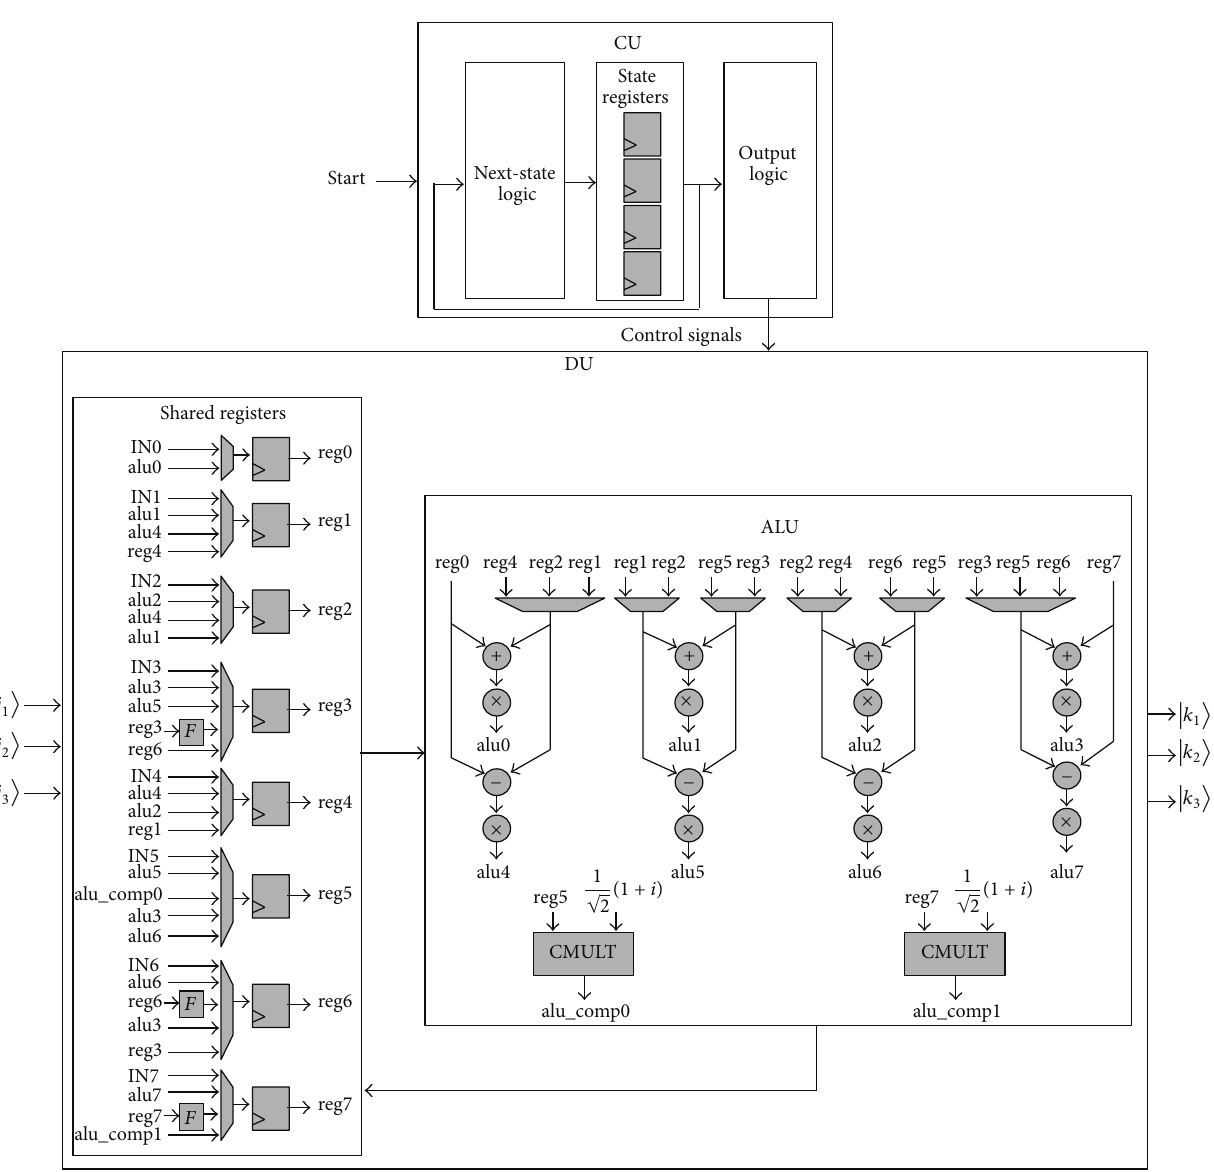
Figure 14: Proposed serial-parallel architecture for 3-qubit QFT. The multipliers shown in this diagram represent the multiplication of input complex number with constant 1/√2 .